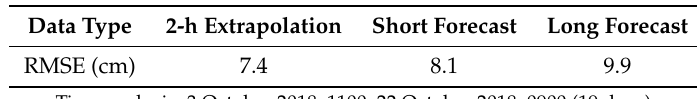
Table 2. Root mean squared error